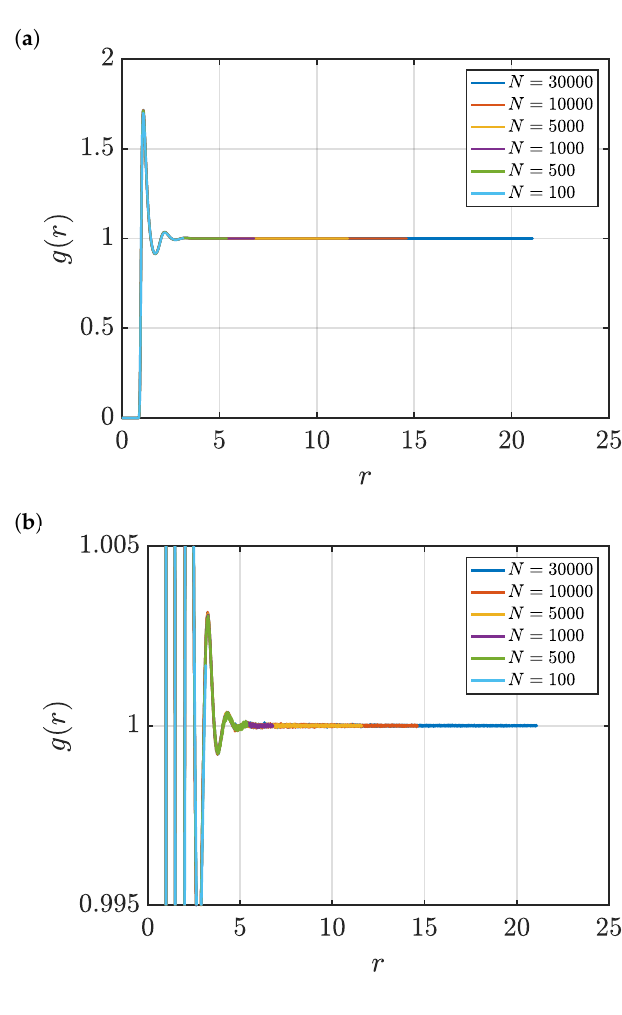
Figure 5. ( a ) RDFs for systems of different sizes of a LJ fluid at T = 2 and ρ = 0.4 (dimensionless units). MD simulations in the NVT ensemble were used to compute g ( r ) , and the Ganguly and van der Vegt correction [26] was applied (Equation (13)). ( b ) A zoom in of the plots in Figure ( a ) is shown.